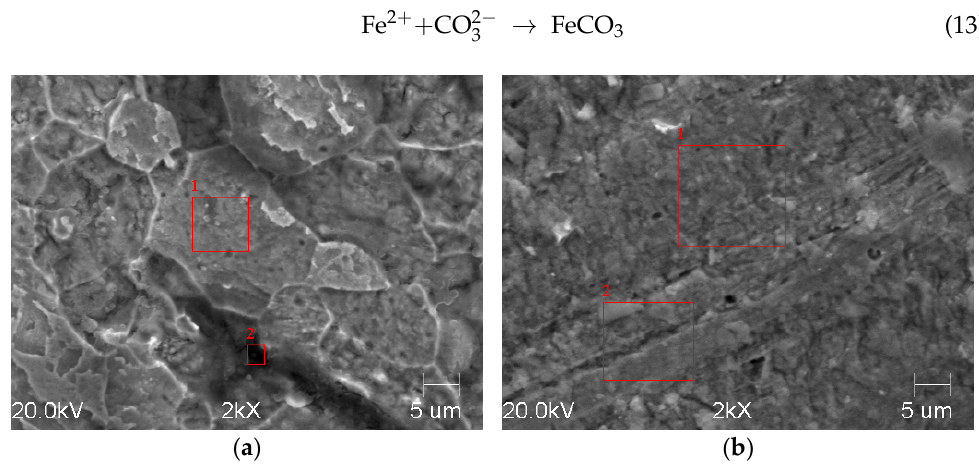
Figure 9. SEM analysis on the sample ( a ) 200 and ( b ) 300, after 24 h of immersion. (The red square area corresponds to the area of the EDS analysis). Table 8. EDS analysis of the tested samples.